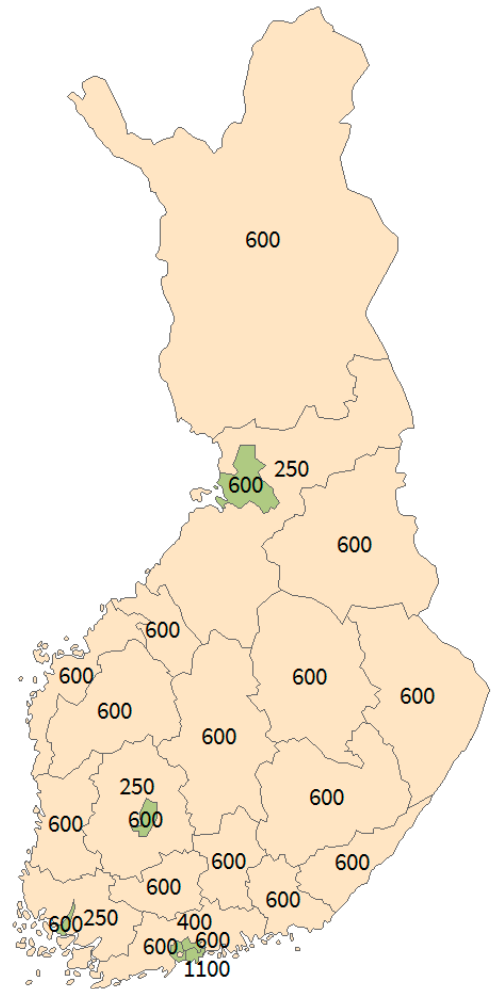
Figure 1. Map of mainland Finland including stratified counties and cities.